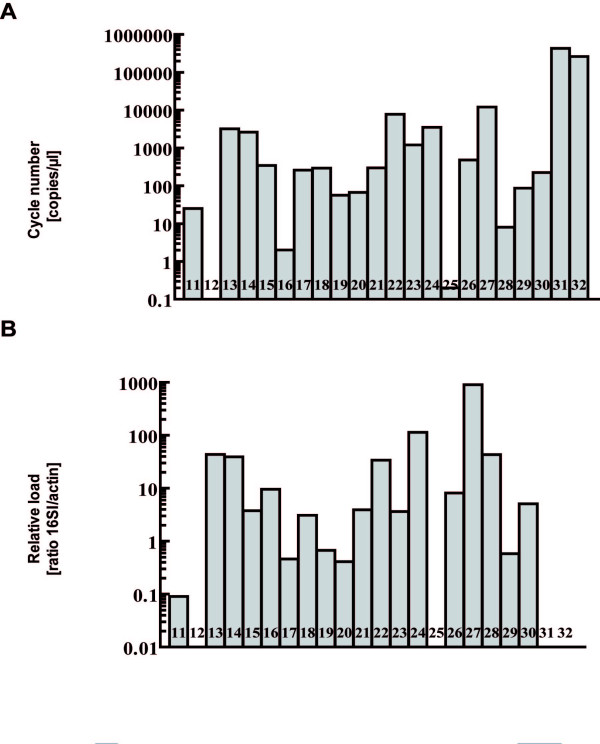
Quantification of 16SI-amplified products by Q-PCR analysis of intestinal DNA preparation. Bacterial DNA was prepared from intestinal specimens obtained from IBD patients as described in Material and Methods, pre-amplified for 10 cycles, diluted 1:100 and further amplified in LightCycler using primers recognizing bacterial 16S subunit (16SI). Data are presented as an absolute number of copies per μl of input DNA (A) or as relative bacterial load calculated as ratio of 16SI-amplicons to β-actin amplicons (B). Note that this calculation is not applicable in the case of porcine fecal samples.